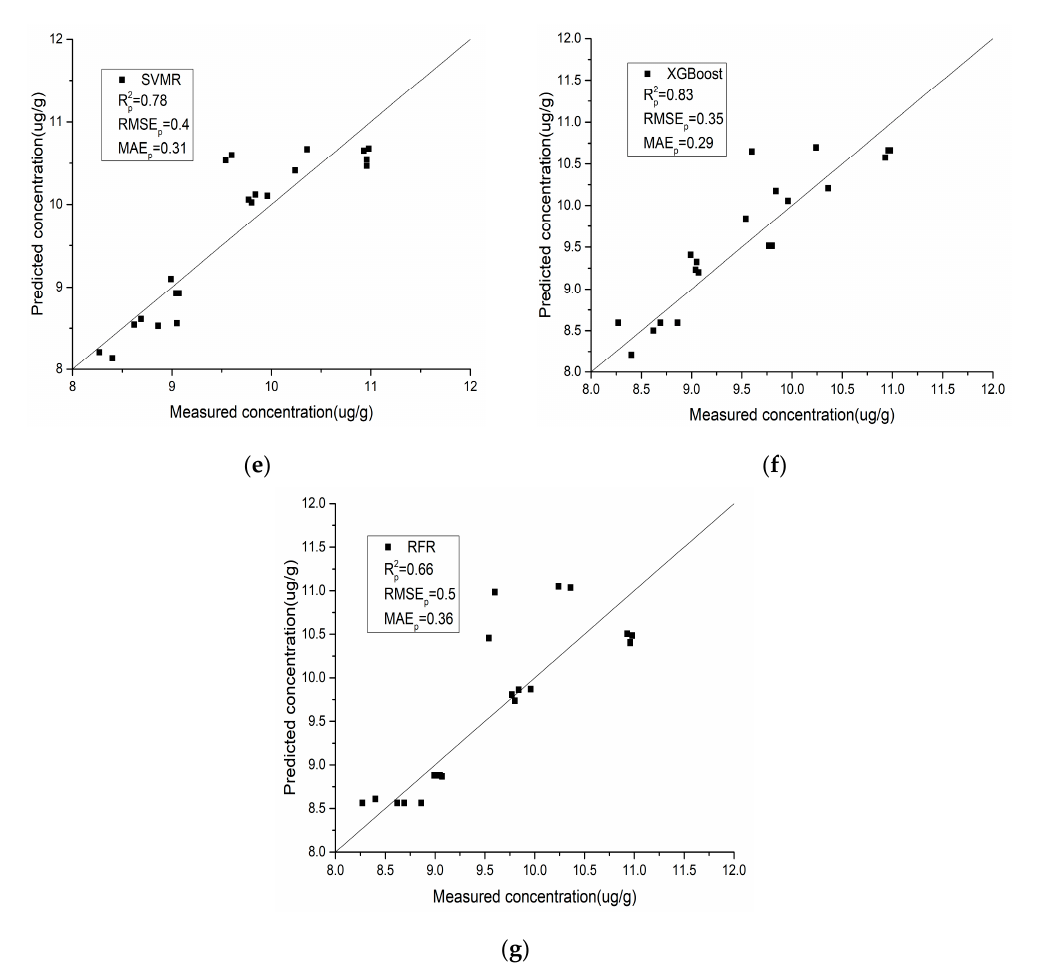
Figure 8. A comparison between the measured values and predicted values of the different regression models using field spectra. ( a ) Partial least squares regression (PLSR); ( b ) Bayesian ridge regression (BRR); ( c ) ridge regression (RR); ( d ) kernel ridge regression (KRR); ( e ) support vector machine regression (SVMR); ( f ) eXtreme gradient boosting (XGBoost) regression; ( g ) random forest regression (RFR).